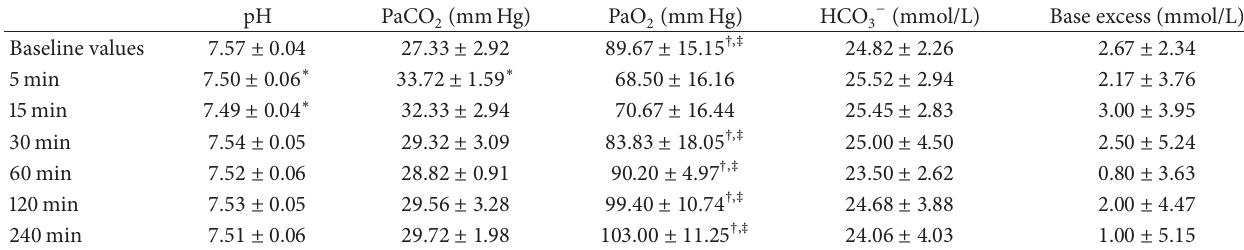
Table 2: Changes in maternal acid-base variables following administration of a single intravenous bolus of 2mg/kg of alfaxalone in a 2- hydroxypropyl- 𝛽 -cyclodextrin formulation (mean ± SD).